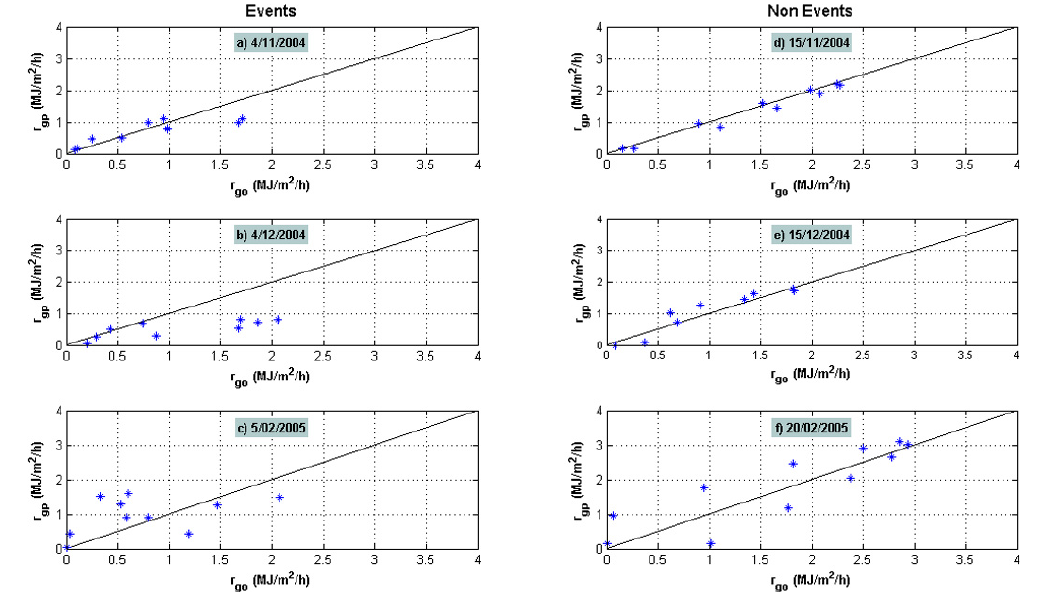
Fig. 7. Scatter plots of observed ( r go ) , and predicted ( r gp ) global hourly radiation (MJm − 2 h − 1 ) at station 802 for certain dates.